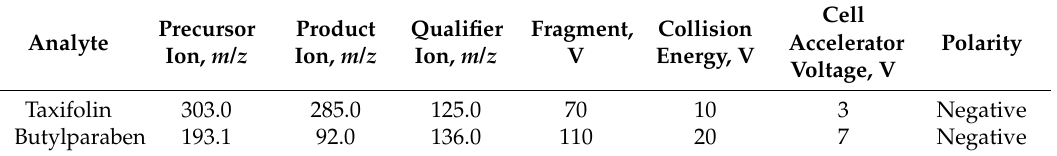
Figure 4. Product ion mass spectra of taxifolin ( A ) and butylparaben (I.S.) ( B ). Table 5. Optimized mass spectrometric parameters for the LC/MS analysis of taxifolin and butylparaben in MRM